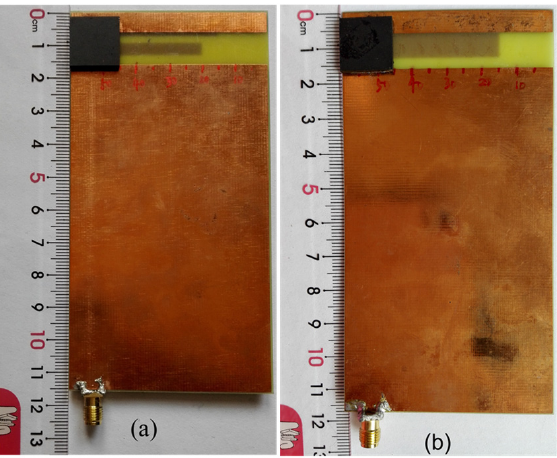
Figure 8. Photograph of the antennas with ferrite slab on bottom layer. ( a ) proposed antenna. ( b ) reference antenna.